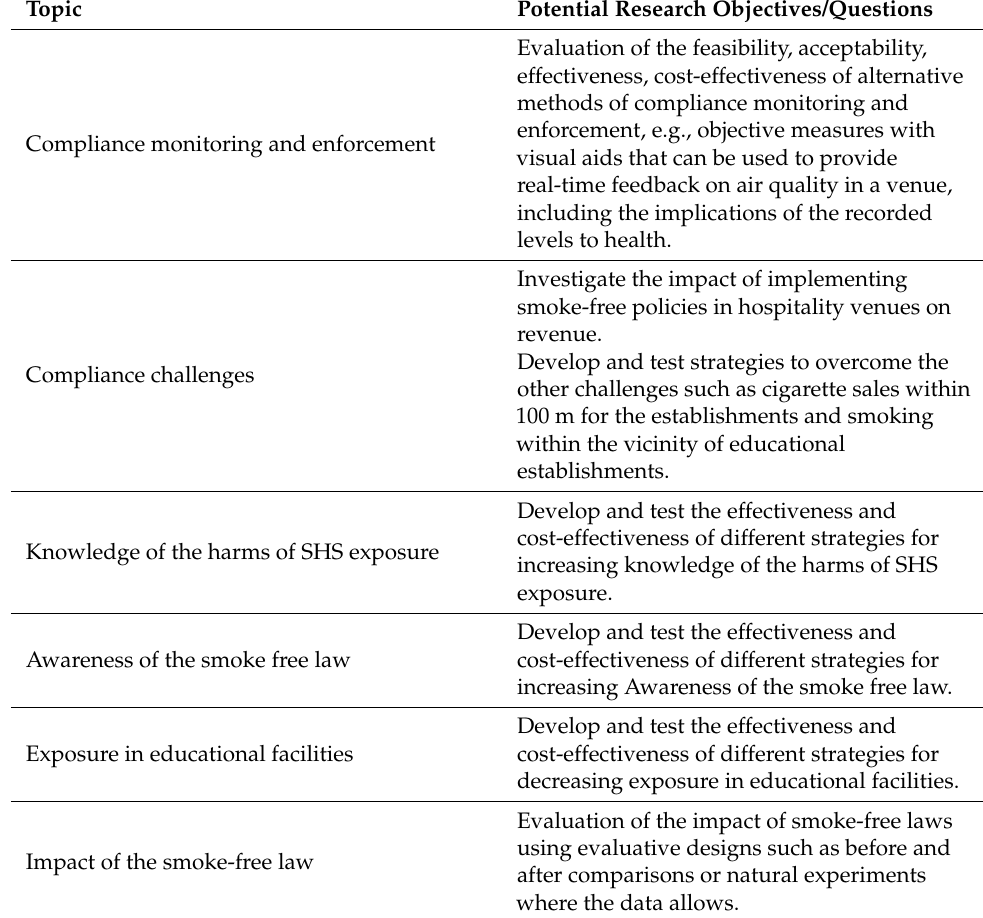
Table 4. Research recommendations drawn from the